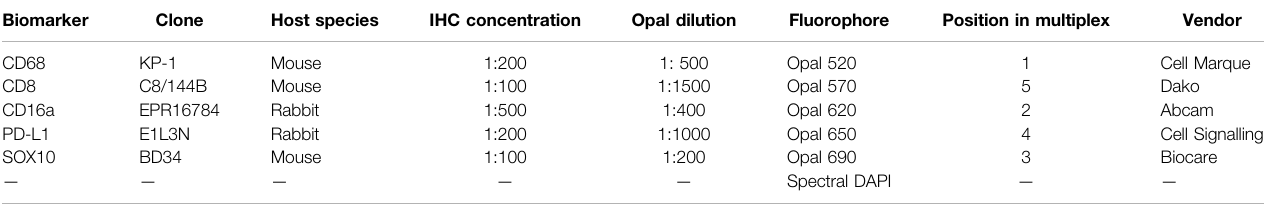
TABLE 1 | Six-plex immuno fl uorescence panel to phenotype melanoma and its tumour microenvironment in FFPE specimens.